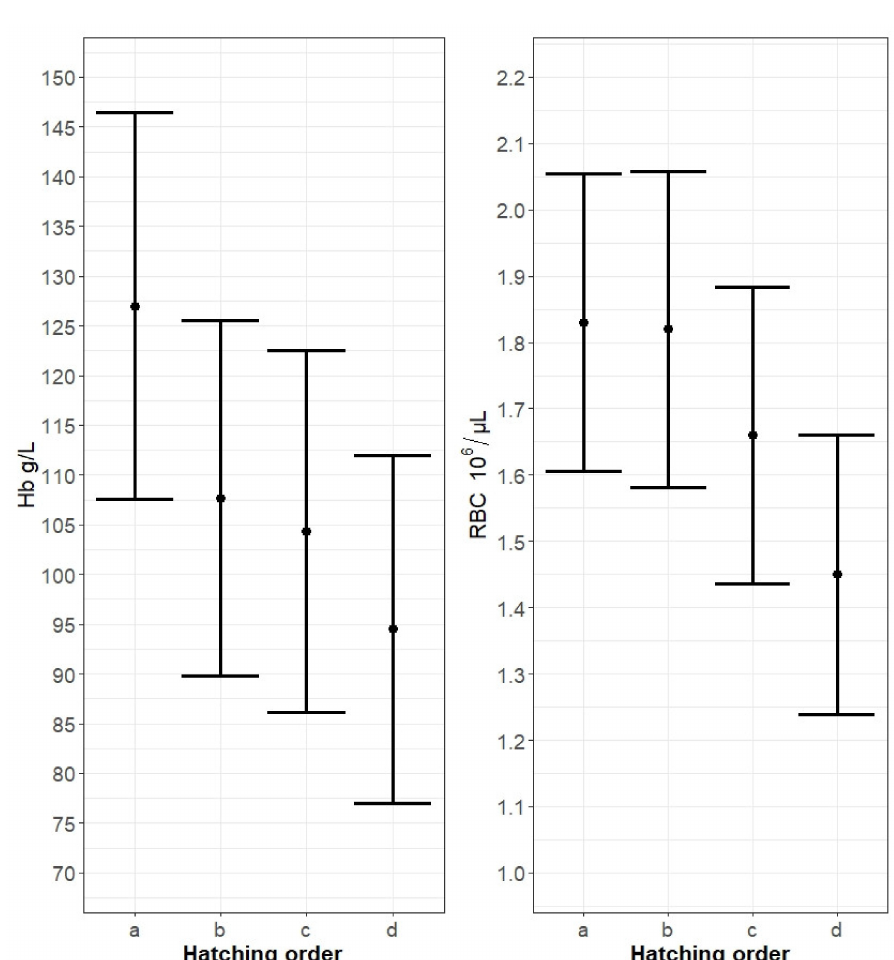
Figure 1. Variation of haemoglobin (Hb) level and red blood cell (RBC) count in the blood of free-living marsh harrier nestlings in relation to hatching order. The hatching order of nestlings is labelled chronologically with letters ( a , b , c , and d ). Modelled means ± standard error (SE) for the best model selected are shown. Values extracted using the lsmeans